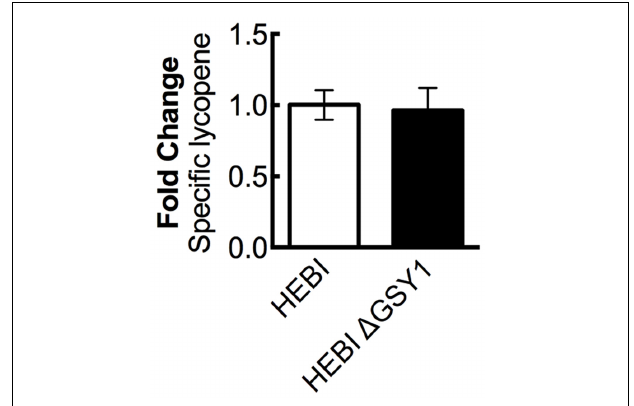
FIGURE 5 | The effect of disrupting glycogen biosynthesis on lycopene production in Y. lipolytica PO1f. Relative specific lycopene content of strains with and without intact glycogen biosynthesis. Strains were grown for 4 days in 25 mL of YPD10 at 30 ◦ C in baffled shake flasks. Bars and error bars represent the mean and standard deviation, respectively, of biological triplicates. Statistical significance from the HEBI strain is indicated by “ ∗ ”. The HEBI strain produced 3.4 ± 0.2 mg lycopene/g